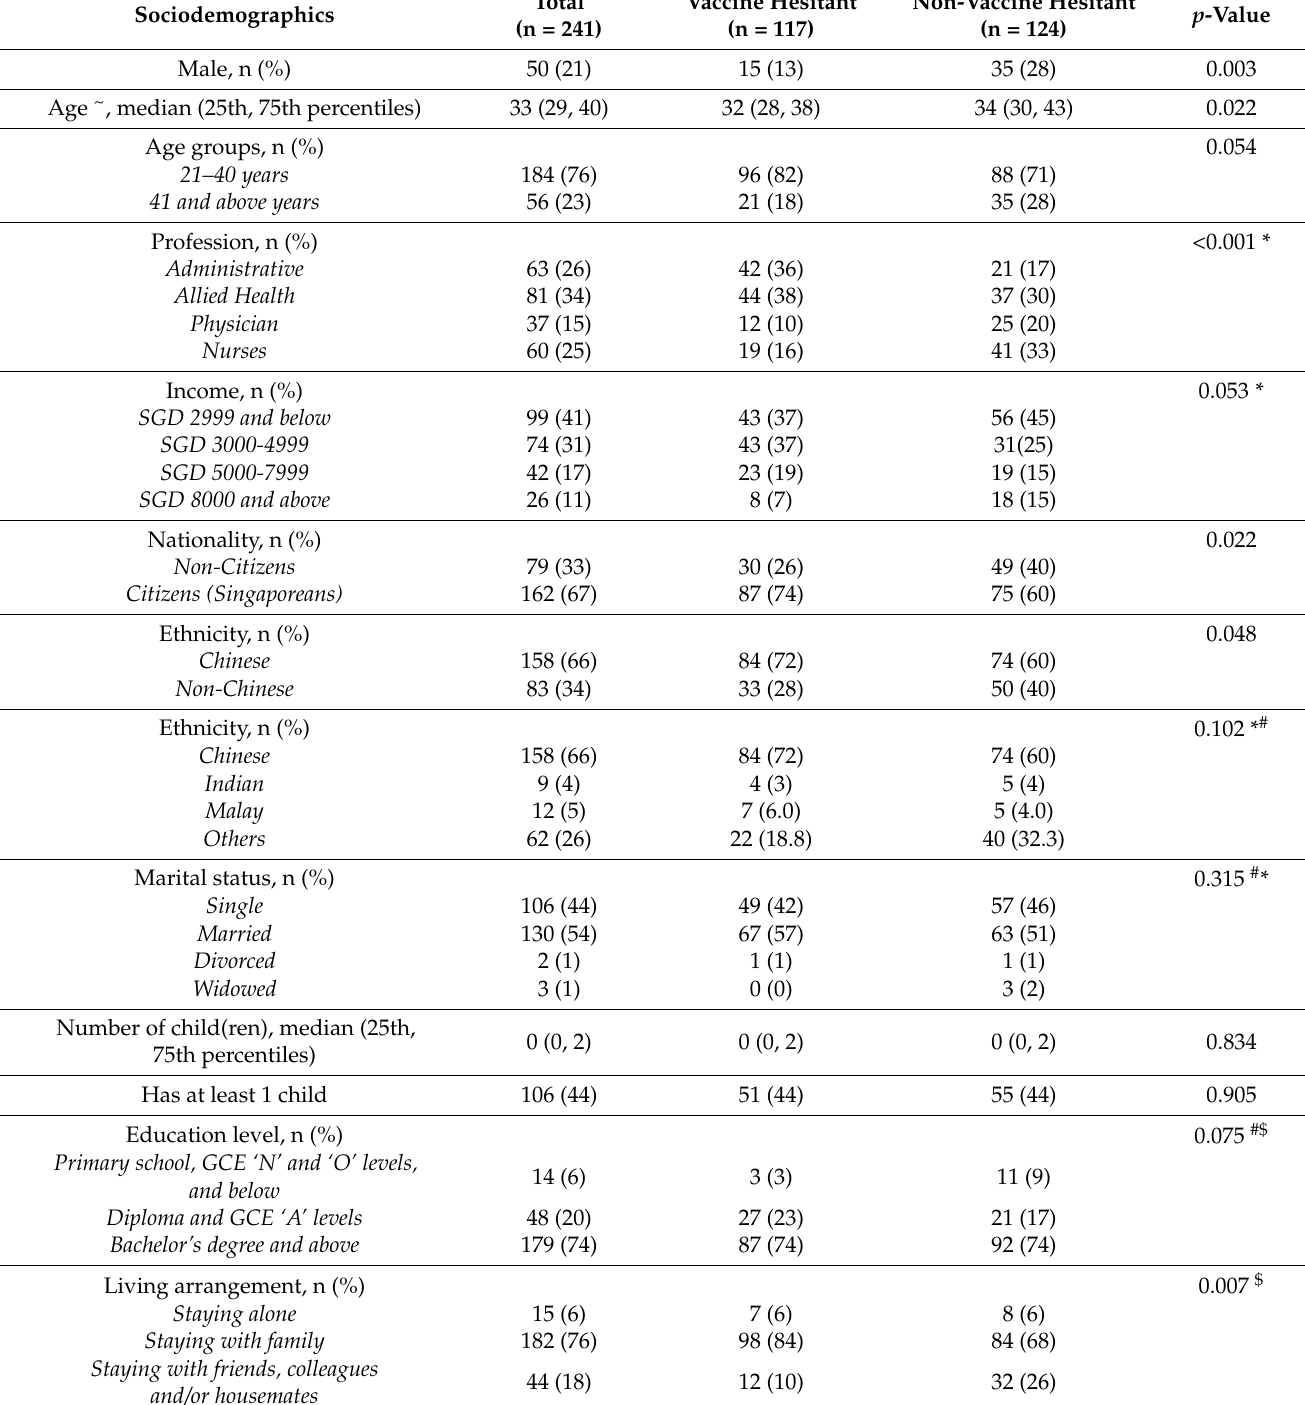
Table 1. Sociodemographic profiles of